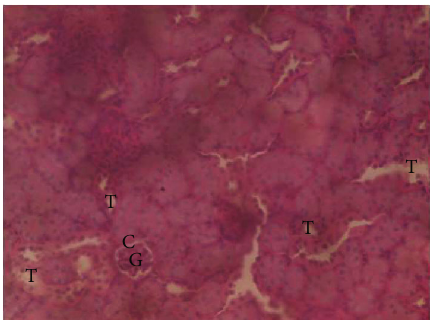
Figure 7: Photomicrographs of the group I animal showing normal kidney of glomeruli (G) containing mesangial cells, mesangial matrix, and capillaries, patent Bowman ’ s capsule (C), and renal tubules (T) lined by simple epithelial cells.